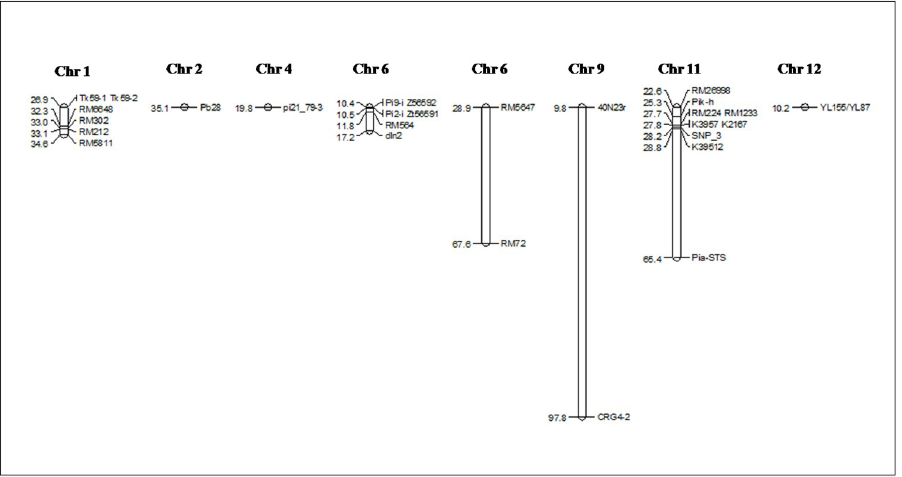
Fig 1. Diagrammatic representation of rice landraces belonged to different states of